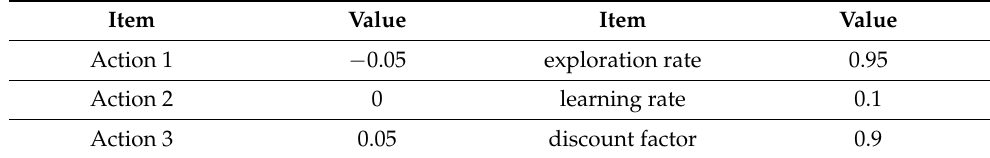
Table 2. Q-learning related